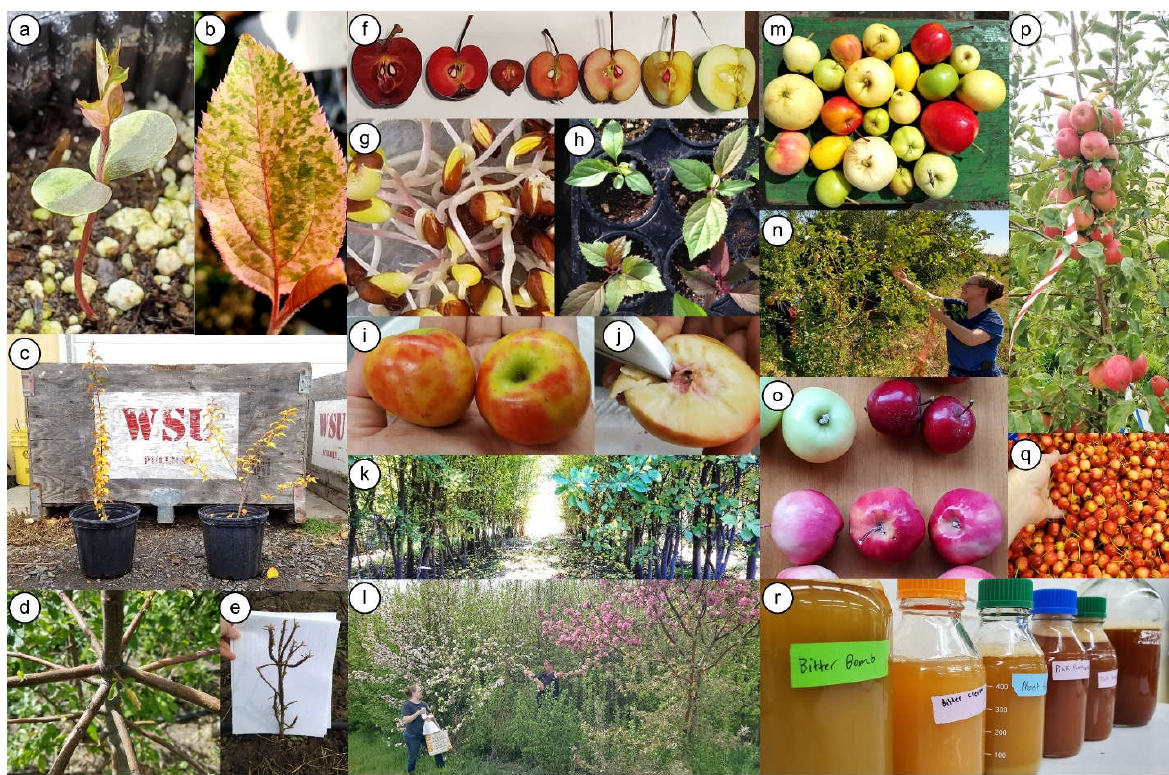
Figure 2. Some interesting phenotypes, parents, and selections arising in the Palouse Wild Cider apple breeding program. Plant/tree phenotypes of interest : ( a ) a variegated seedling given the moniker “Tiamat” that germinated in early 2020 from crossing a seedling of “Red Jade open-pollinated” with ‘Pendragon’; ( b ) “Tiamat” leaves have sectors of light and dark green, white/yellow, and pink/red; ( c ) two offspring of M. × zumi × ‘Wijcik McIntosh’ in fall 2017, showing segregation for the columnar branching habit of the paternal parent; ( d ) right-angled branching, commonly observed in offspring of ‘Kerr Crab’ and some M. sieversii parents; ( e ) a dwarfed seedling with many nodes and very short internodes, one of the many offspring from open pollination in 2013 of GMAL 2330 ( M. baccata ). Red flesh and leaves : ( f ) ‘Robert’s Crab’ (left), homozygous for the red flesh allele, has been the most common source of red flesh in the program, with each offspring inheriting one allele exhibiting one of many degrees of flesh redness, from the deep and vibrant red of “Red 11” and “Red 1” (second and third from left, respectively) to just redness at the core and seeds as in “Red 2” (second from right); ( g ) inheritance of the red-flesh allele is detectable in newly germinating seedlings by their pink radicles; ( h ) leaf color of program seedlings ranges from green for those with no red-flesh allele (top left) to some degree of redness for those with one red-flesh allele, having some to all leaves being reddish-green (top right and bottom left) to all leaves being vibrantly red (bottom right); ( i ) fruit in fall 2020 of the diploid selection “Red Io” resulting from the crossing in 2014 of an accession of M. ioensis and ‘Robert’s Crab’; “Red Io” has the typical red-green leaves of a